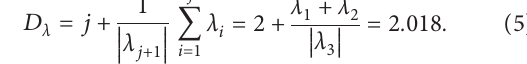
Figure 2: The time series of 3D jerk system (1) in x